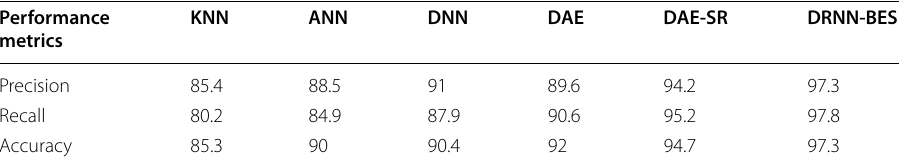
Table 3 Dice’s coefficient based performance comparison Performance metrics